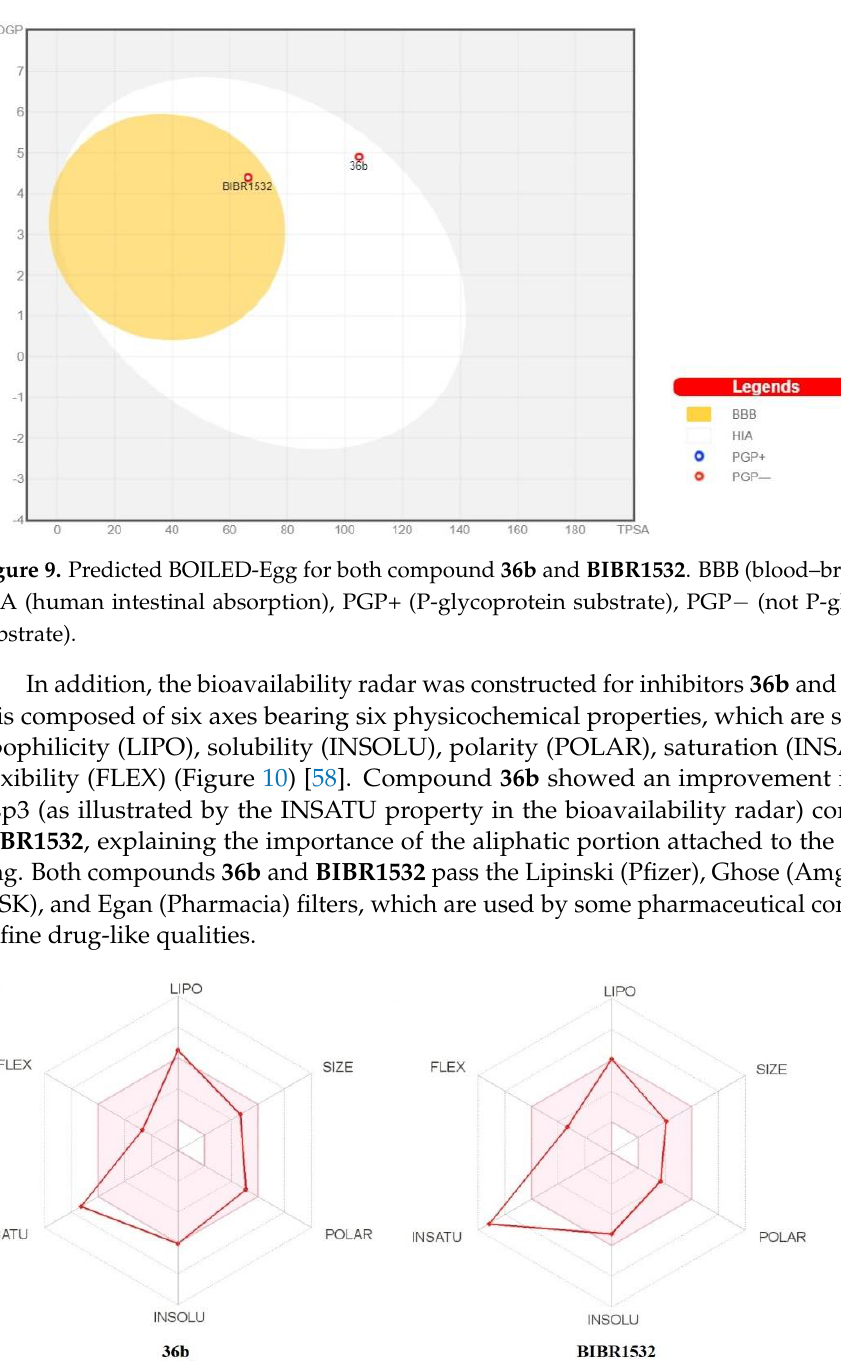
Figure 10. Bioavailability radar for compounds 36b and BIBR1532 . The red line represents each Figure 10. Bi оа v а il а bility r а d а r f о r c о mp о unds 36b а nd BIBR1532 . The red line represents e а ch structure, and the range of optimal property values for oral bioavailability is shown in